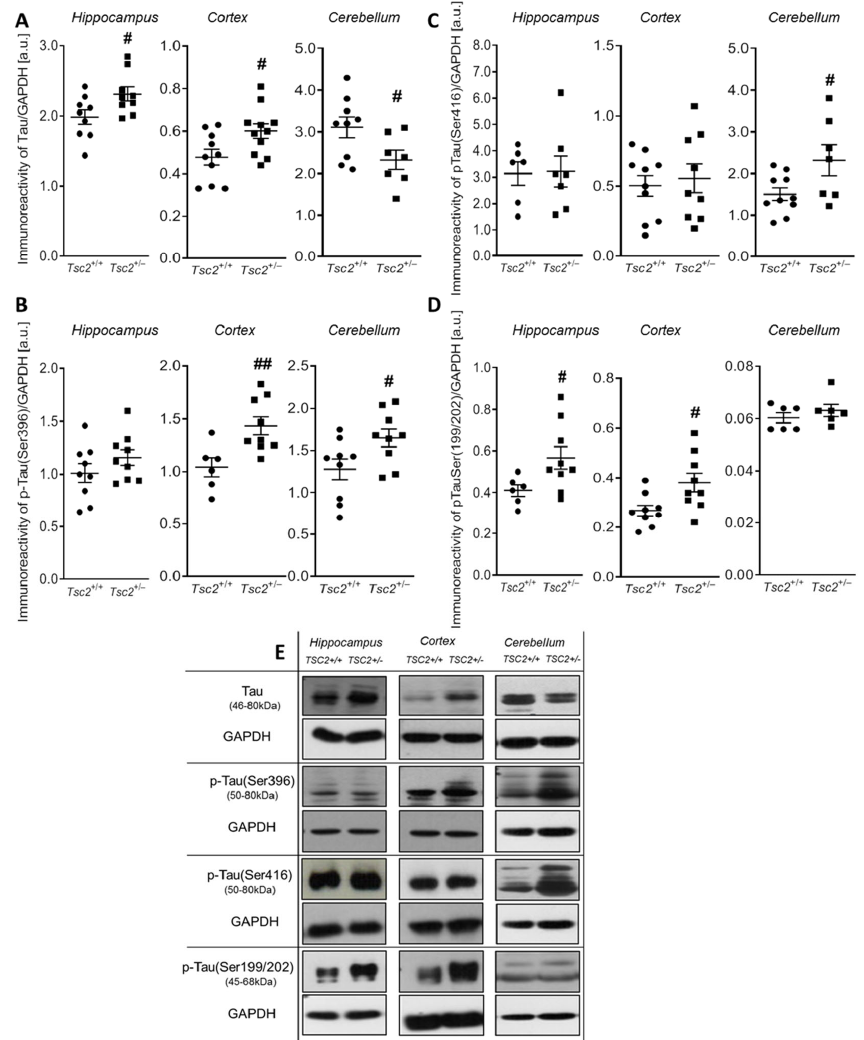
Figure 3. The effect of Tsc2 haploinsufficiency on the protein level and Tau phosphorylation in the mouse brain. Immunoreactivity of total Tau and pTau (Ser396), pTau (Ser199/202), and pTau (Ser416) in control and Tsc2 +/ − mice, was monitored using Western blot analysis. Densitometric analysis of total Tau ( A ), pTau (Ser396) ( B ), pTau (Ser416) ( C ), and pTau (Ser199/202) ( D ), as well as the representative pictures ( E ) in the hippocampus, cerebral cortex, and cerebellum, were shown. Results were normalized to GAPDH levels. Data represent the mean values ± SEM from n = (7–11) separate animals for Tau, n = (6–9) separate animals for pTau (Ser396), n = (6–10) separate animals for pTau (Ser416), and n = (6–9) separate animals for pTau (Ser199/202) from three different litters. Data were analysed using Student’s t ‐ test. # p < 0.05, ## p < 0.01, vs. control (wild ‐ type animals).